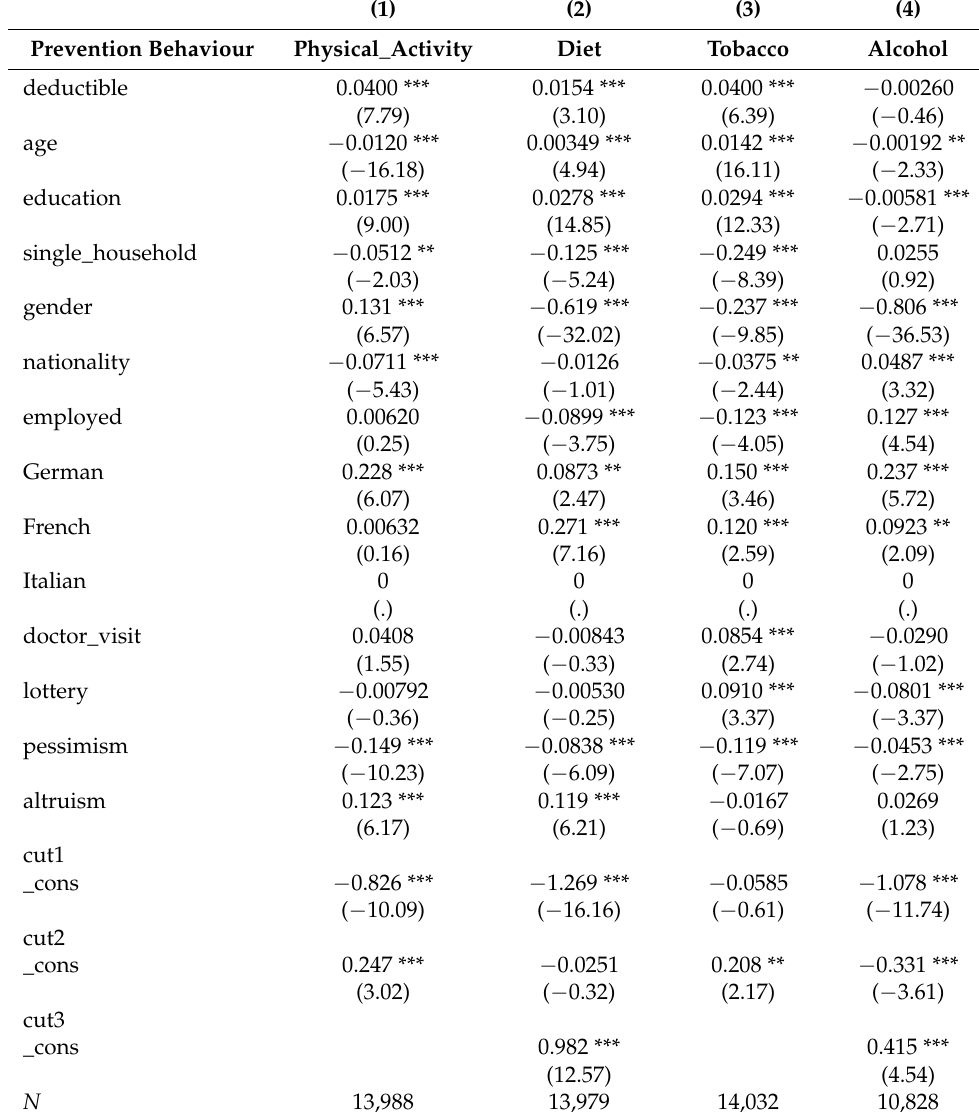
Table 4. Baseline